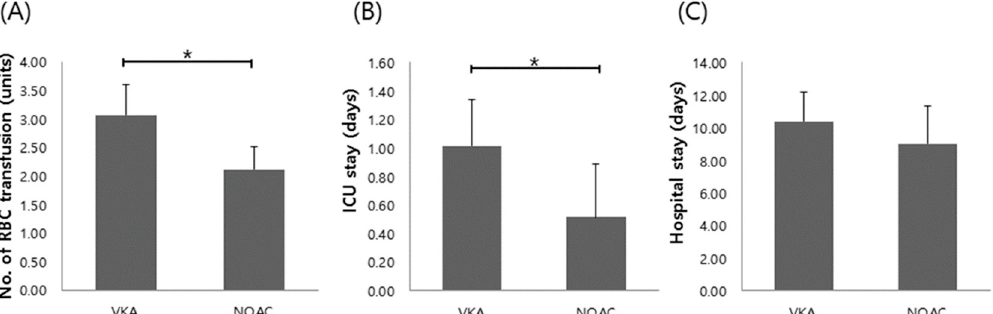
Figure 2. Clinical outcomes related to the severity of GI bleeding in patients on NOACs vs. VKA ( A ) number of red blood cell transfusion, ( B ) duration of ICU stay, ( C ) duration of hospital stay in patients treated with VKA and NOACs. * p < 0.05. VKA, vitamin K antagonist; NOAC, new oral anticoagulants; RBC, red blood cell; ICU, intensive care unit.